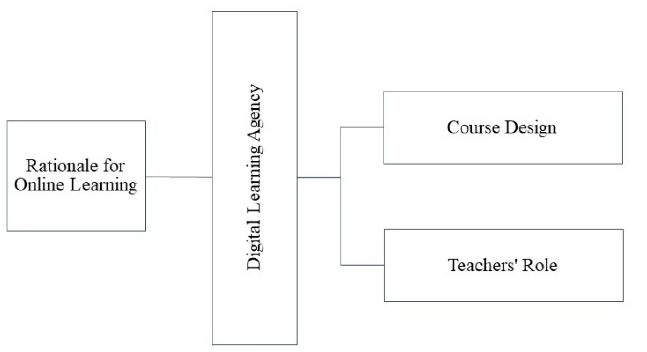
Figure 4. Factors influencing the effectiveness of the online programming learning environment for middle school